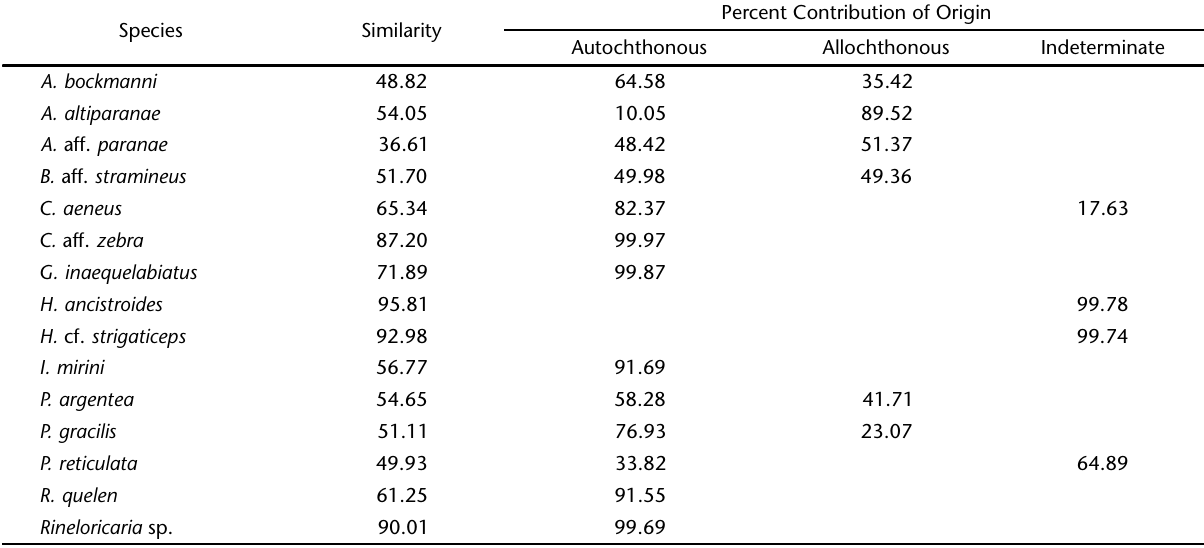
Table IV. Values obtained via SIMPER analysis according to the origin (autochthonous, allochthonous and indeterminate) of the item consumed by the fifteen species. Species Similarity